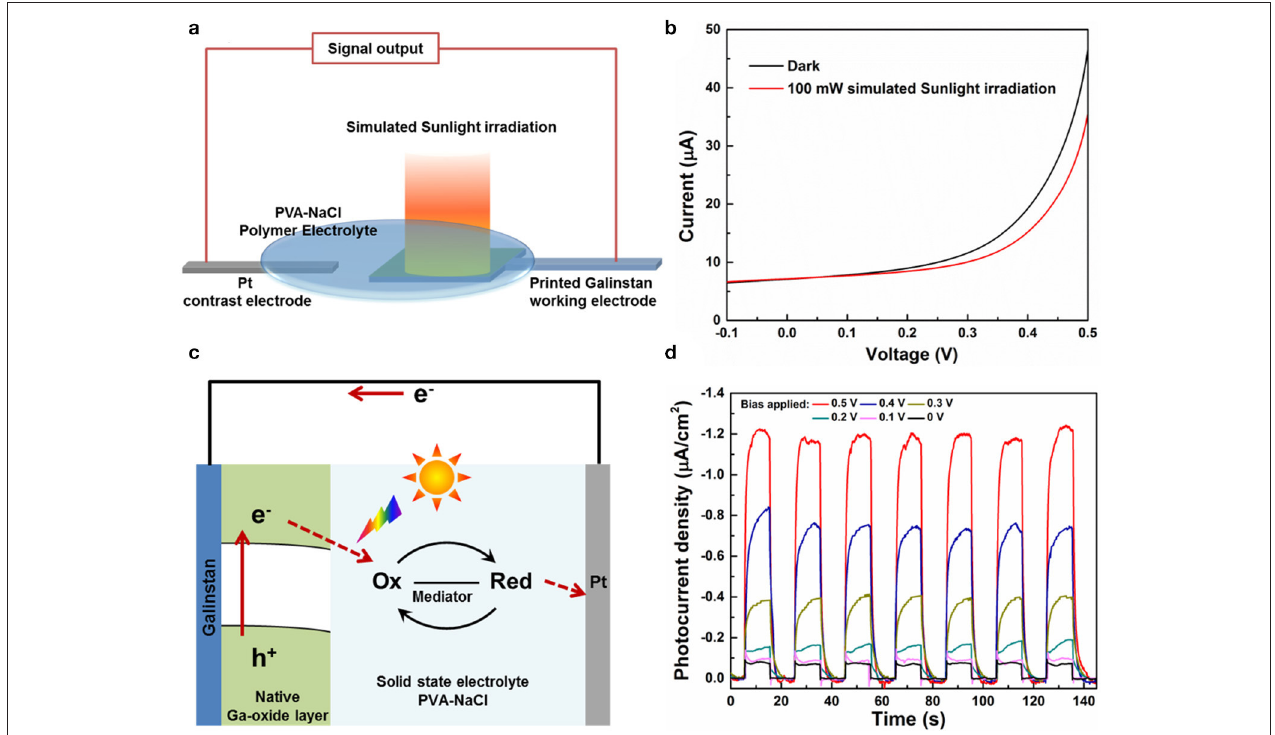
FIGURE 3 | (a) Schematic illustration of the PEC device and test system. (b) Current-voltage relationship (I–V) of the printed galinstan electrode. (c) Schematic illustration of the working mechanism of the as-constructed PEC device. (d) Normalized photocurrent density of printed galinstan PEC device at different bias potentials (0V, 0.1V, 0.2V, 0.3V, 0.4V, 0.5V, vs. the Pt electrode) with the on-off switching operation of 100 mW · cm − 2 simulated Sunlight irradiation.